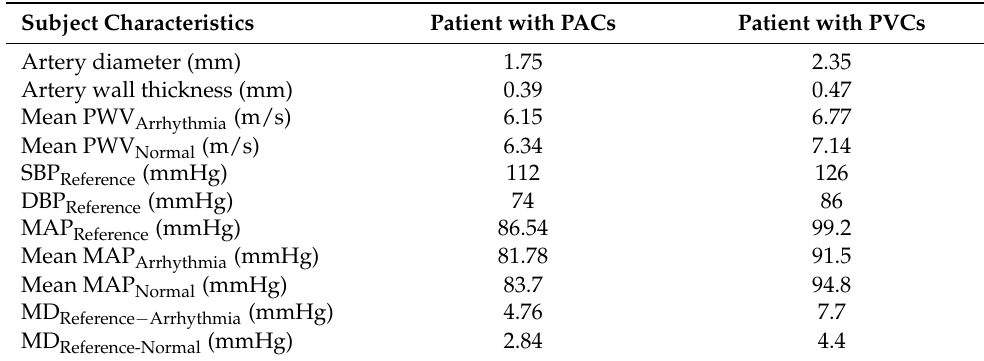
Table 4. Physiological parameters of the PAC/PVC